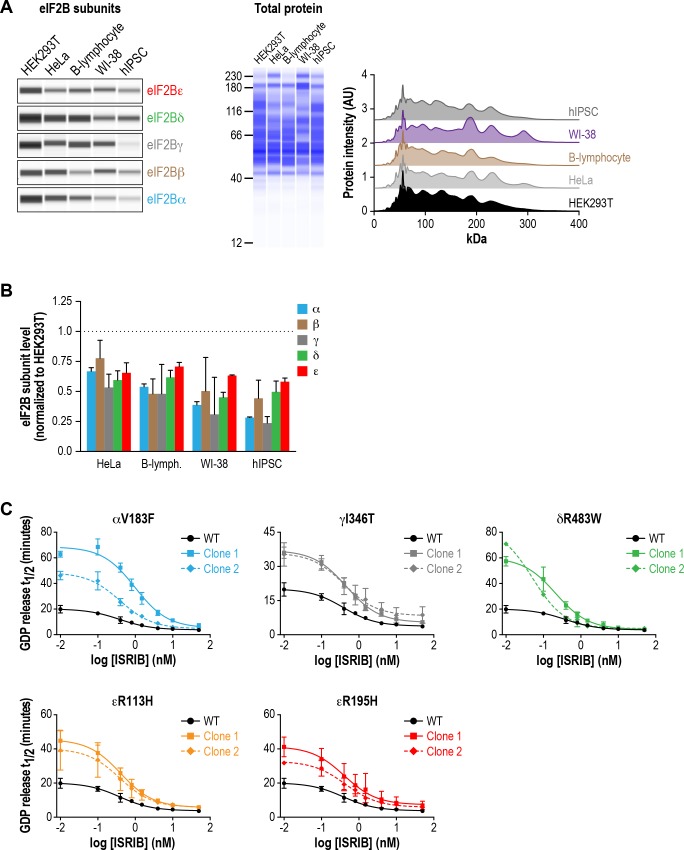
Lysates from VWMD cells exhibit reduced GEF activity in vitro that is enhanced by ISRIB.(A) Levels of the five eIF2B subunits were measured by immunoblotting (Wes analysis) of lysates from different cell lines. The cell lines were: HEK293T (human embryonic kidney, SV40-transformed), HeLa (adenocarcinoma), primary B-lymphocyte (EBV-transformed), WI-38 (normal lung fibroblast) and hIPSC (human induced pluripotent stem cell). The protein concentration of each lysate was normalized to 0.2 mg/mL and 0.2 μL of each sample was loaded onto the Wes instrument. Representative images of eIF2B subunits and total protein are shown. An intensity trace of total protein in each Wes capillary is also shown, confirming equal protein loading. (B) The chemiluminescence signal of each subunit was normalized to HEK293T subunit levels (N = 2, mean ± SD). All subunits were significantly different from HEK293T (p<0.01) with the exception of HeLa eIF2Bβ, which was not significant. (C) ISRIB dose-response curves of GDP release half-life for the eIF2B VWMD mutants. Half-lives of GDP release at each ISRIB concentration were calculated by fitting single-exponential decays to the Bodipy-FL-GDP fluorescence decay curves. Data from the WT curve is reproduced in each of the VWMD mutant plots as a solid black line for comparison. Every VWMD lysate exhibited reduced GEF activity compared to WT lysate, which could be rescued by ISRIB in a dose-dependent manner. Each point represents 9 measurements from three independent experiments (mean ± SD).